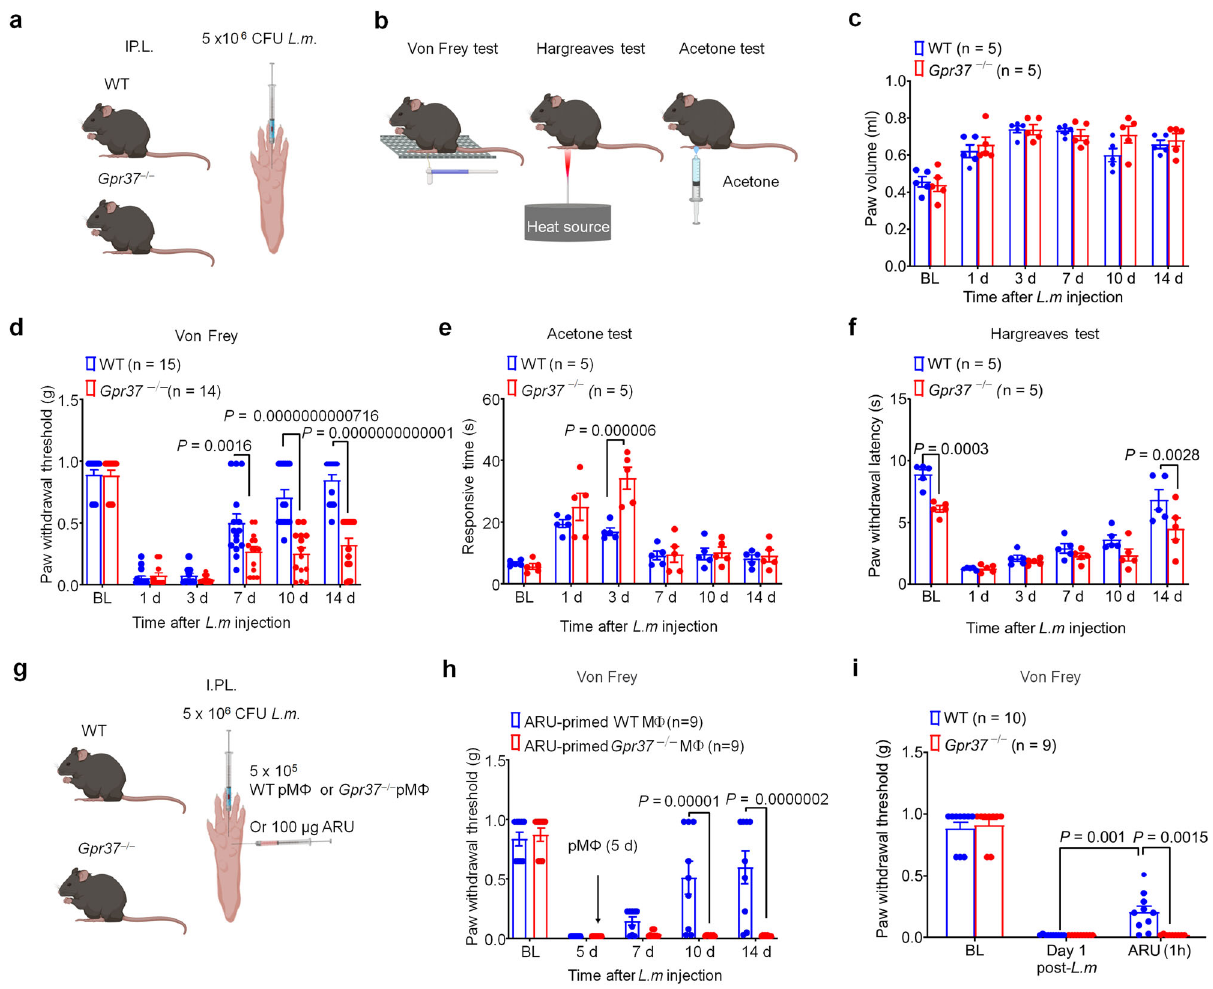
CFU) was administered via intraplantar (I.PL.) into the mouse hindpaw, where pain-like behaviors can readily be assessed. b Methods used to